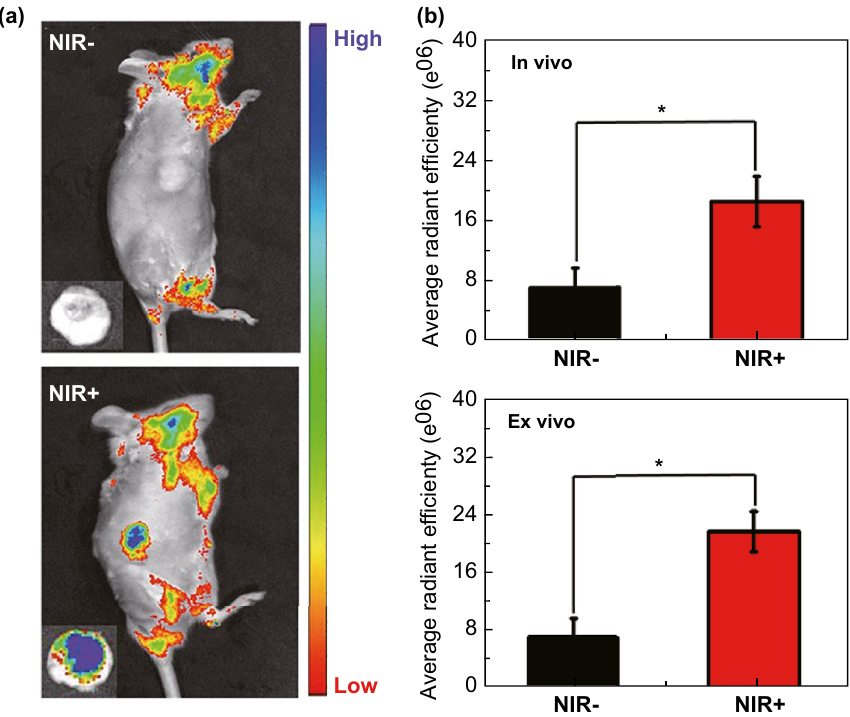
Fig. 6 a Fluorescence imaging photographs of the mice with and without 808 nm irradiation. Inset: the corresponding tumor. b Quantitative average radiant efficiency of the tumors in and ex vivo. Both mice were injected with Bi 2 Se 3 @AIPH NPs. * p < 0.05, ** p <